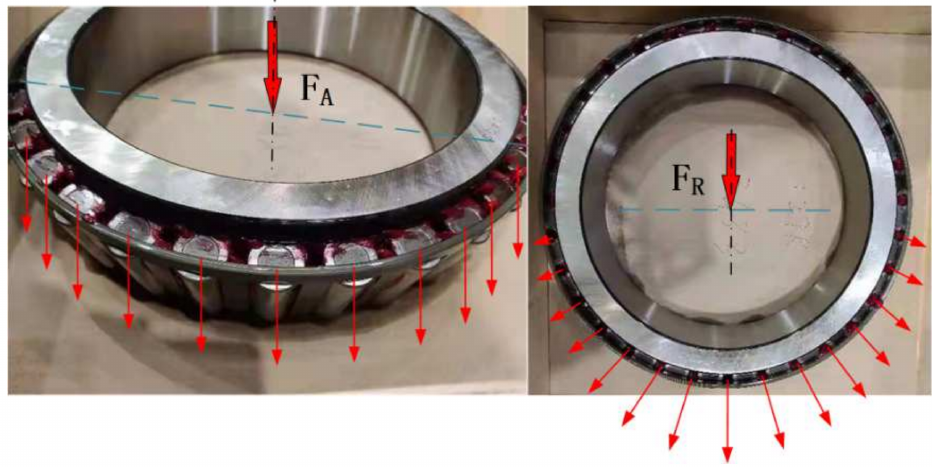
Figure 1. The axial and radial loads on the axles slew bearing in electric